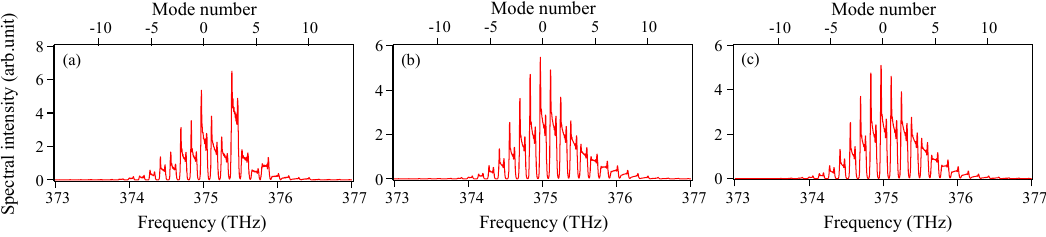
Figure 6. Examples of averaged spectra when ( a ) 5; ( b ) 100; ( c ) 2000 different single-shot spectra are summed, with Langevin noise included.